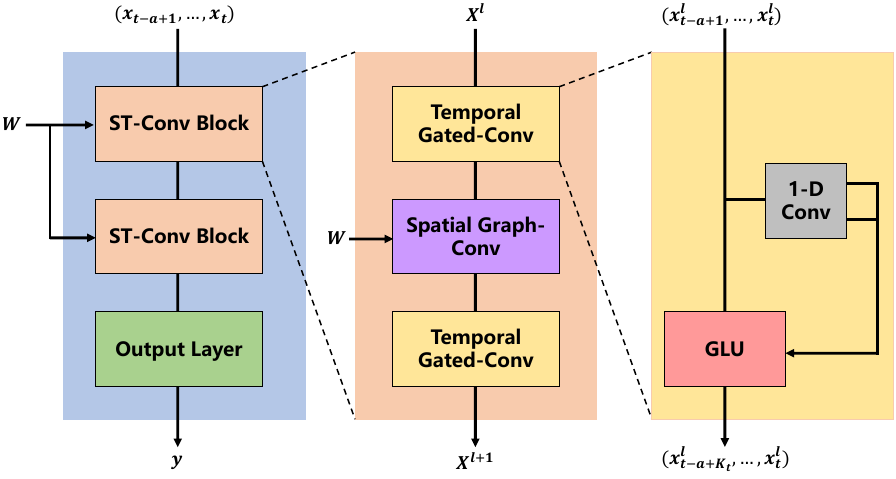
Figure 5. The architecture of the STGCN model, which consists of two ST-Conv blocks and a fully connected output layer. ( x t − a + 1 ,..., x t ) is the a historical records, y is the predicted results, and X l is the input of the l th ST-Conv Block. There are two Temporal Grated-Conv blocks and one Spatial Graph-Conv block in each ST-Conv block, where the Spatial Graph-Conv block is in the middle of the two Temporal Grated-Conv blocks. One-dimensional convolution is used in the Temporal Grated-Conv blocks, followed by GLU activation. The full name of GLU is Gated Linear Unit, and it can reduce the vanishing gradient problem for deep architectures by providing a linear path for the gradients while retaining nonlinear capabilities [34] . The equation of GLU is GLU ( x ) = ( xW + b ) (cid:12) σ ( xV + c ) , where x is the input of GLU, W , V , b , c are the parameters to be learned, and σ is the sigmoid activation